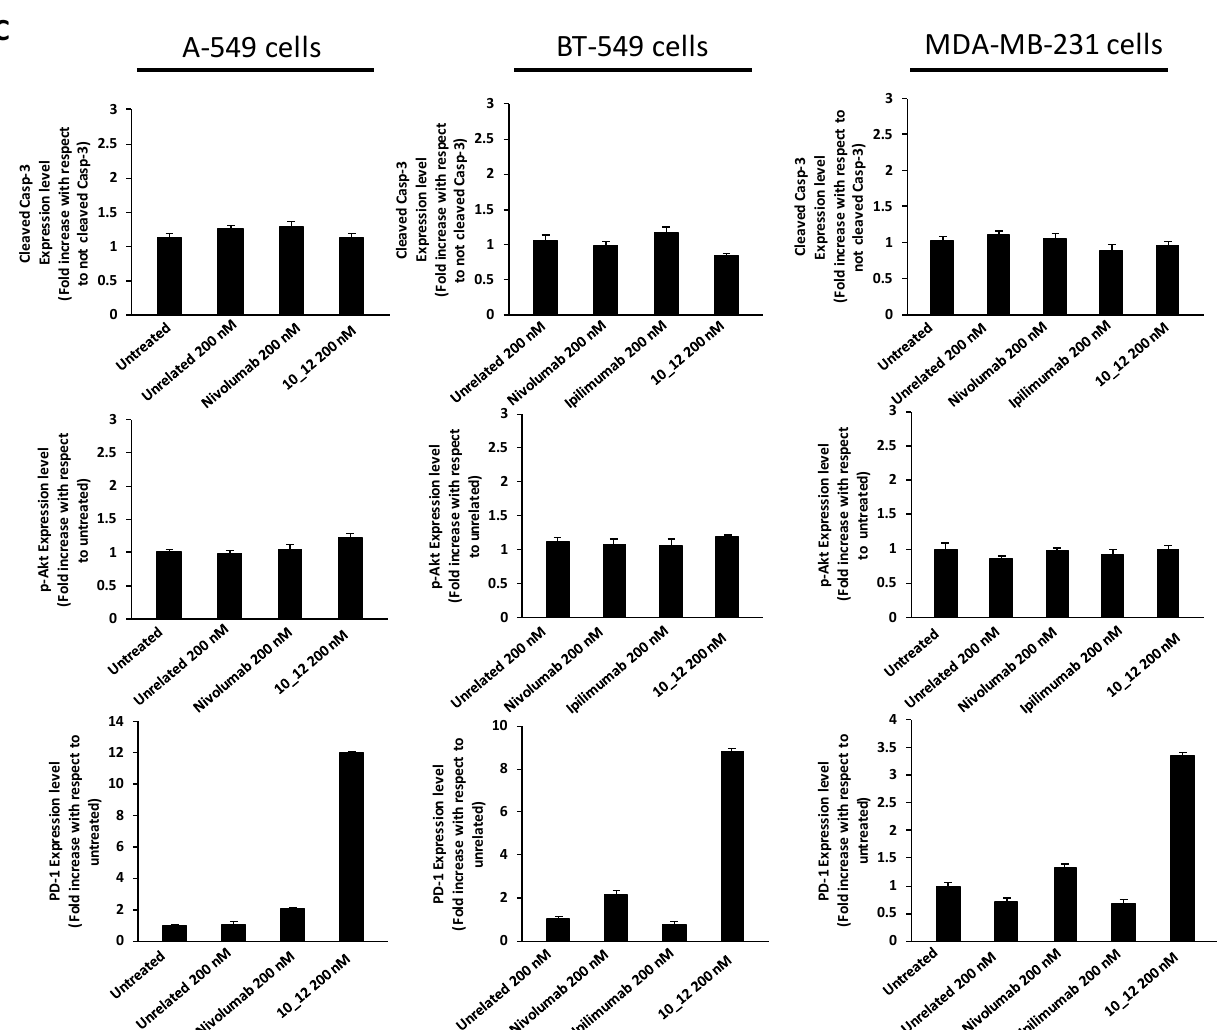
Figure 2. Immunomodulatory mAbs reduce tumor cell viability by affecting intracellular pathways. ( A ) A-549, BT-549 and MDA-MB-231 tumor cells were treated for 72 h with anti-PD-1, anti-PD-L1, anti- CTLA-4 or unrelated (anti-SRB1 or anti-Claudin 1) mAbs at the indicated concentrations. Cell survival is expressed as percentage of viable cells with respect to untreated ones. Cells were counted before and after Trypan Blue exclusion test. The values were reported as the mean of at least three determinations obtained in three independent experiments. Error bars depict means ± SD *** p < 0.001; ** p < 0.01; * p < 0.05; ns, not significant. ( B ) Western blotting analyses of extracts from MDA-MB-231, BT-549 or A-549 tumor cells treated for 72 h as indicated. Images of the whole Western blots are included in Figure S4. The intensity of the bands was normalized to vinculin. ( C ) Densitometry quantification of signals from Western blotting analyses. Protein levels are expressed as fold increase with respect to cells untreated or treated with an unrelated IgG; cleaved Caspase-3 level is expressed as fold increase with respect to uncleaved Caspase-3.